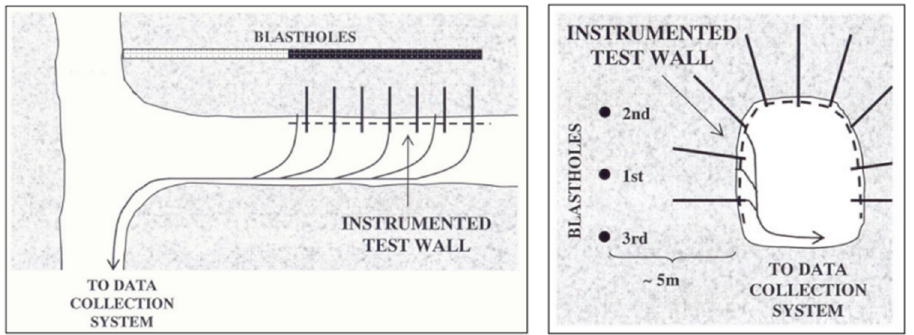
Figure 1. Concept diagram of blasting.